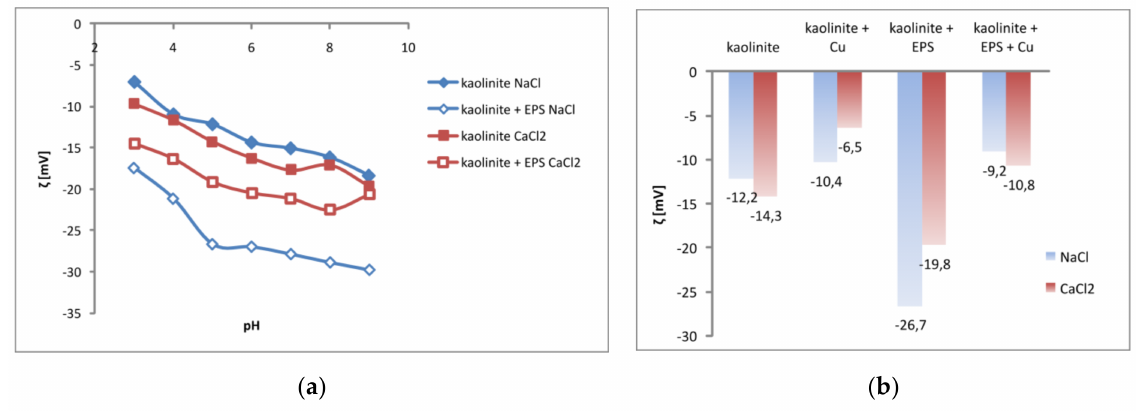
Figure 6. Zeta potential ( ζ ) of kaolinite in the absence and presence of EPS (100 mg/L) in the NaCl or CaCl 2 solution ( a ), as well as in the systems containing only Cu(II) ions (100 mg/L) or Cu(II) ions and EPS simultaneously ( b